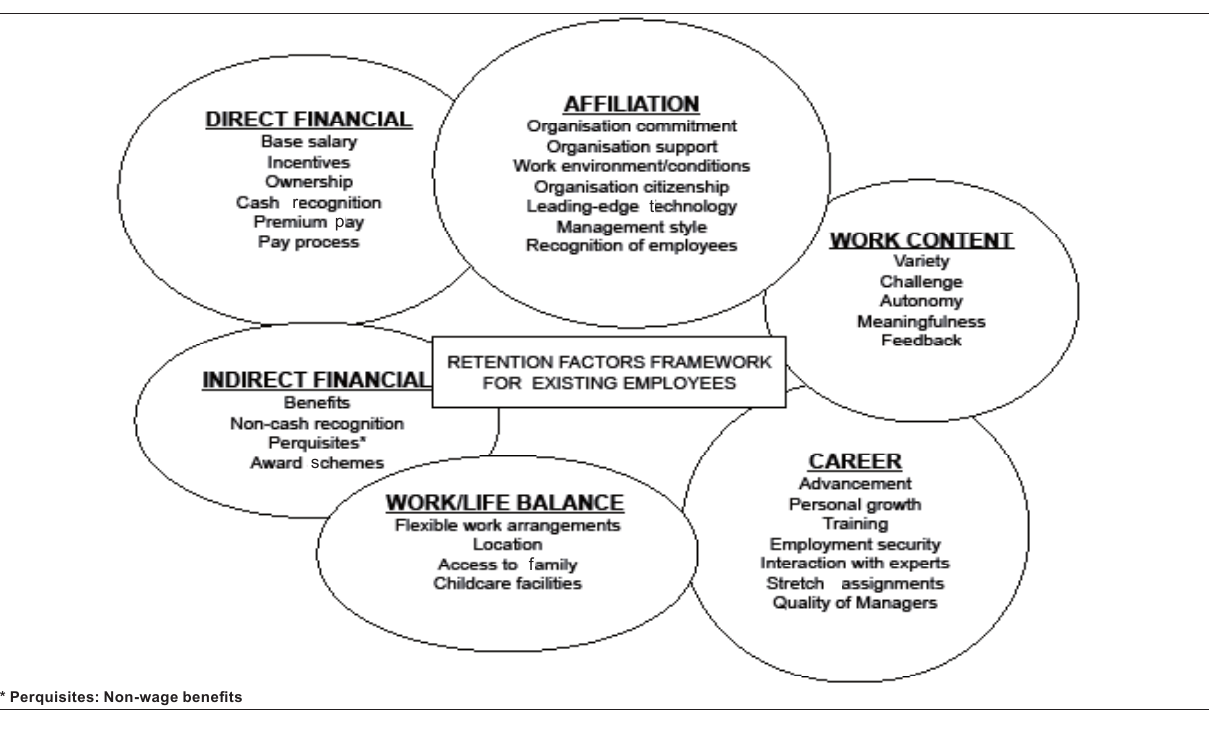
FIGURE 1 Retention Factors Framework for Existing Employees (adapted from Britton et al. ,